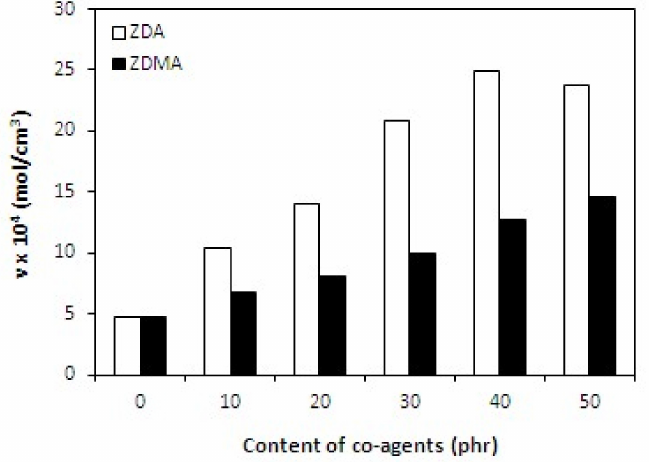
Figure 2. Influence of co-agents content on cross-link density ν of